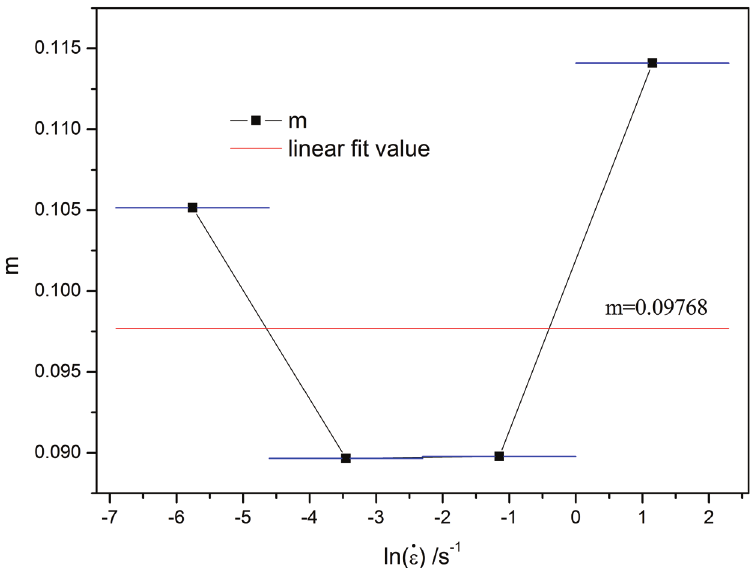
Figure 7: Relationship between m and ln ð _ ε Þ .